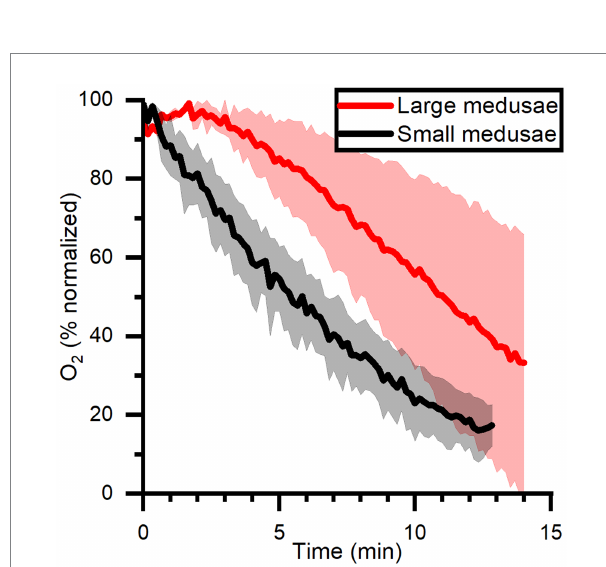
FIGURE 7 O 2 dynamics measured in mid-bell mesoglea (roughly halfway deep in the bells) of large and small medusae from onset of darkness at 0 min, after a previous illumination with an incident photon irradiance (400–700 nm) of 580 μ mol photons m − 2 s − 1 . Data is normalized against maximum oxygen concentration measured in each medusa, and then averaged for large ( n = 2) and small ( n = 3) individuals ±